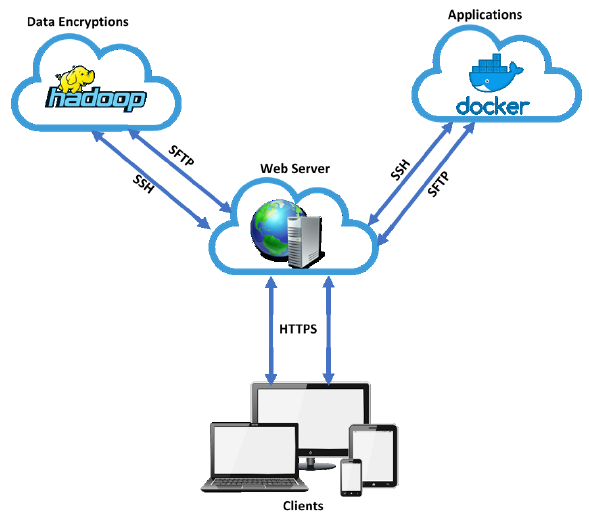
Figure 1 | The general architecture of our